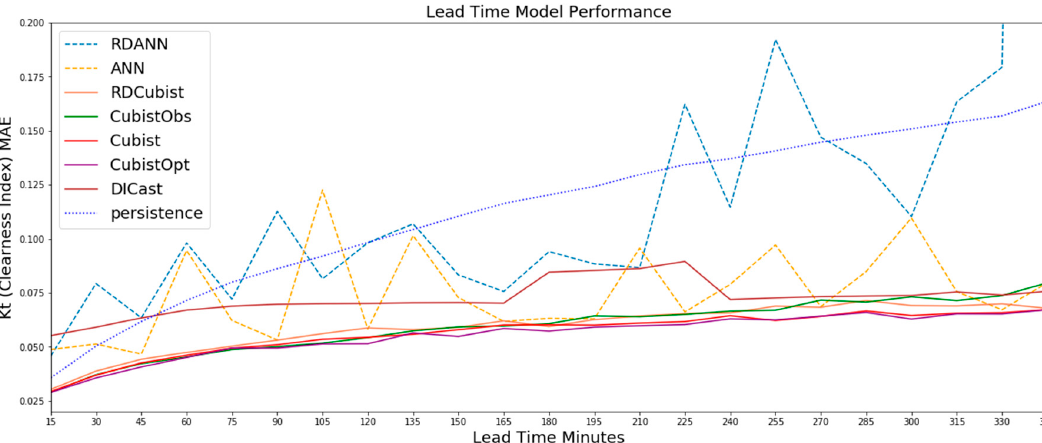
Figure 2. The results on the test dataset for all methods show that the Cubist-based methods (solid color lines) all perform considerably better with lower MAE than the other methods with the CubistOpt method having a small improvement over the other Cubist methods. The ANN based approaches (dashed lines), especially the RD-ANN method, performs the worst on nearly all lead times.